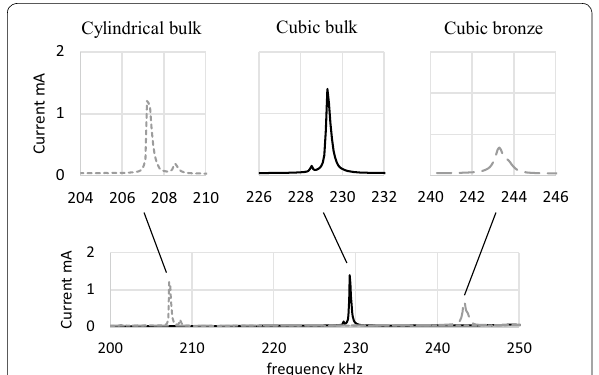
Fig. 6 Frequency characteristic of the velocity measured by laser Doppler